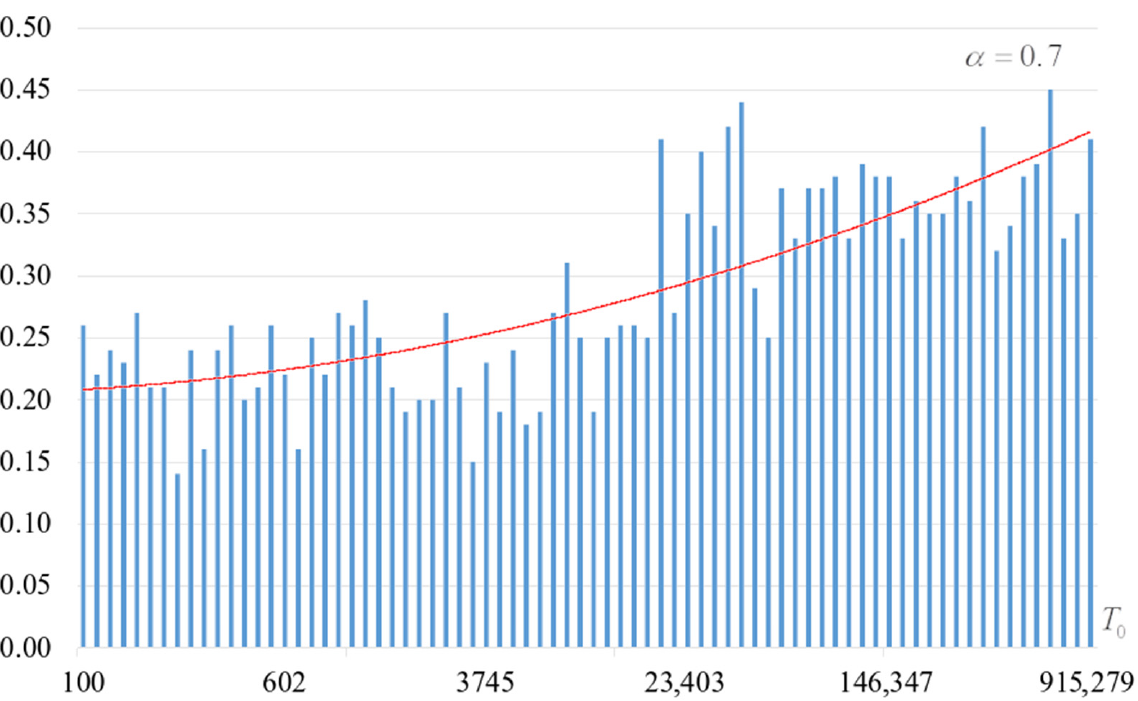
α= α= . Figure 3. The probability of forming the target S-box at α = .